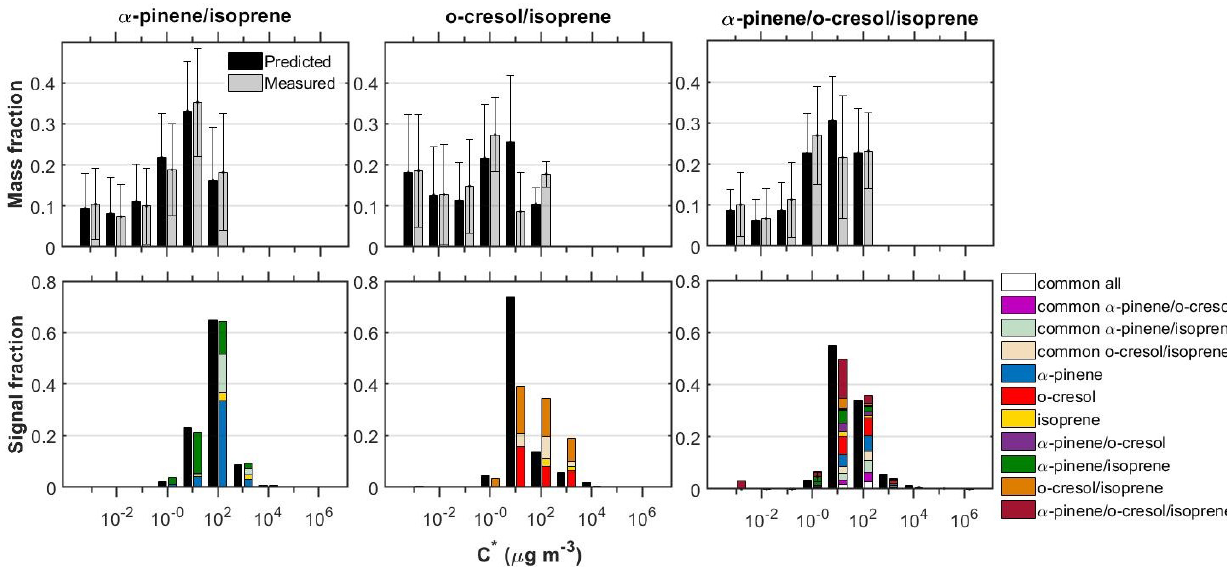
Figure 3. Measured and predicted SOA particle volatility distributions from the TD measurements ( ± retrieval uncertainty) (top panels) and from the FIGAERO-CIMS measurements (bottom panels) in all the mixed systems investigated. The volatility distributions from the FIGAERO-CIMS with ± 1 σ are shown in the Supplement (Fig. S3). The coloured bars in the top and bottom panels represent the mea- surements and the black bars the predictions. The coloured bars in the bottom panels are separated to show the signal contributions of the products in each volatility bin. “Common” was classified as the products that were identified in each mixture as well as at the respective single-precursor experiments of that mixture. The remaining products had elemental formulas that were unique to each single-precursor or mixture